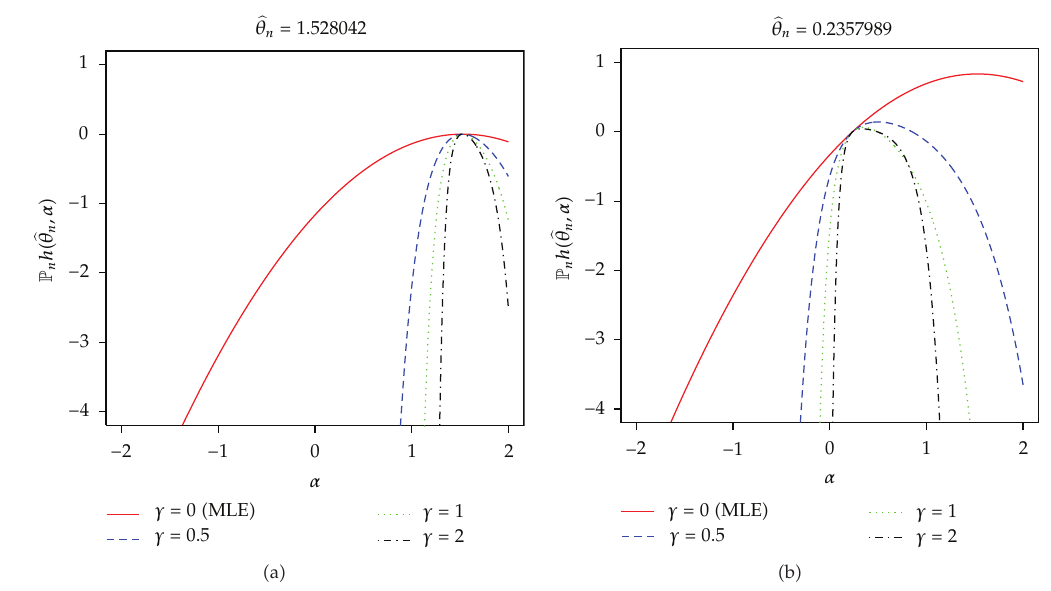
Figure 2: Criterion for the normal location model under